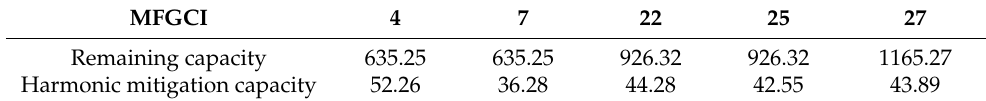
Table 5. Capacity of each MFGCI involved in harmonic mitigation